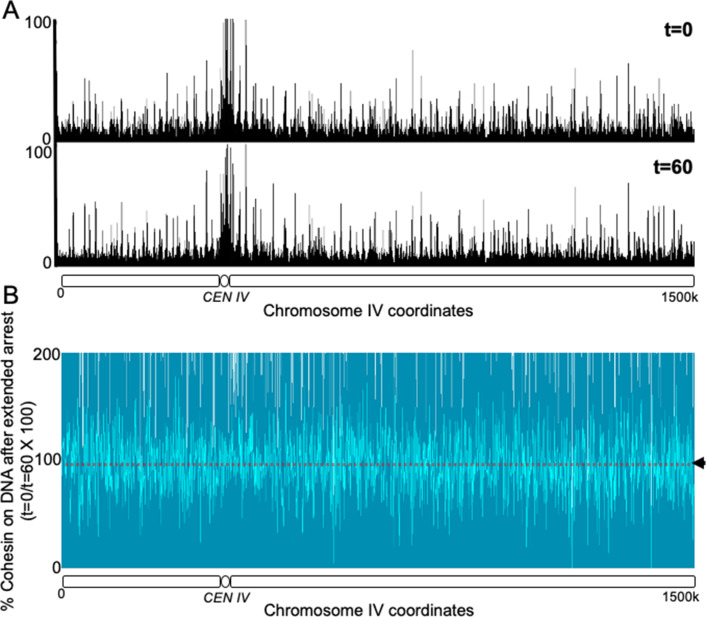
Non cleavable cohesin expressed in the G2 phase survives mitosis and remains stably associated with the chromosomes in the subsequent G1 phase.(A) 6C non cleavable cohesin was expressed for 45 min in Wild type (K24697) strain arrested in G2 phase. The culture was released from the G2 arrest and arrested in the subsequent the G1 phase, a sample of the culture was drawn at this stage and fixed with formaldehyde (time 0). The rest of the culture was maintained in a prolonged G1 arrest by regular addition of the mating pheromone α-factor for a further 60 min. A sample was drawn at 60 min (time 60) and fixed with formaldehyde. The 0 and 60 min samples were subjected to calibrated ChIP sequencing with anti-PK antibody. The occupancy of Scc1NC along the entire chromosome IV is shown for both t = 0 and t = 60 min samples. (B) The difference in the level of Scc1NC-PK (time 60/time0) between the two conditions is shown as % of cohesin that remains on DNA upon prolonged G1 arrest. The median cohesin levels across the entire chromosome IV (dotted line) is marked with an arrowhead.